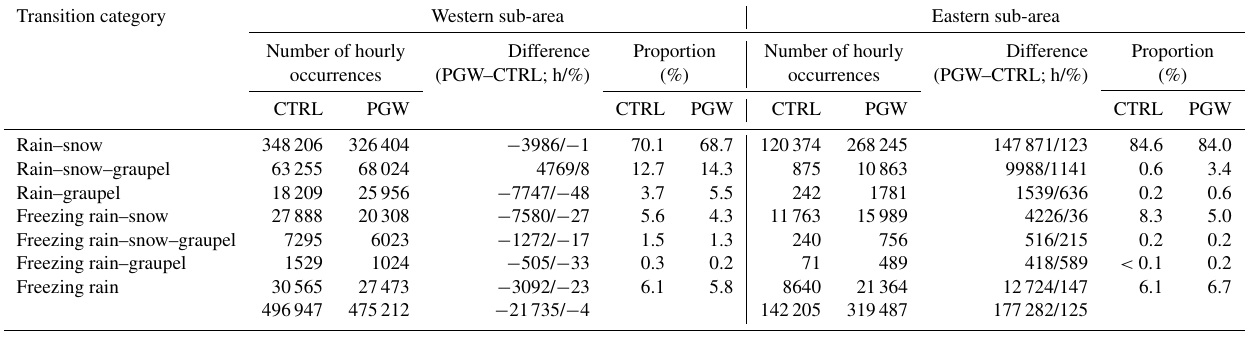
Table 3. Number of hourly occurrences under each transition region category, along with their differences over both the western and eastern sub-areas, separated at 121 ◦ W. Occurrences in each category are shown as a proportion in their respective sub-areas and under PGW do not add up to 100% due to rounding. Average elevations and total sum of occurrences are shown for the western and eastern sub-areas.